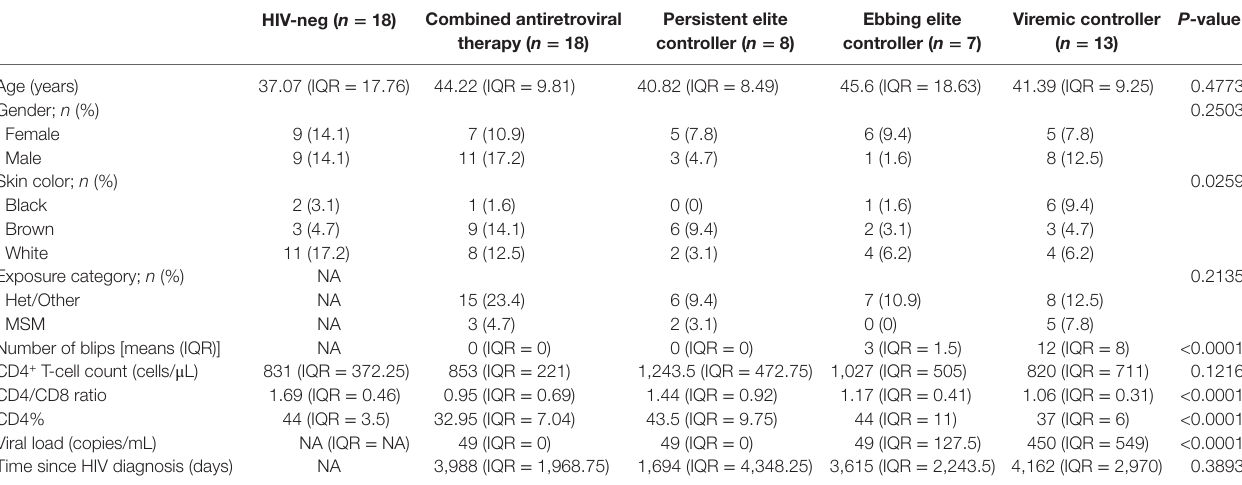
TaBle 1 | Individuals’